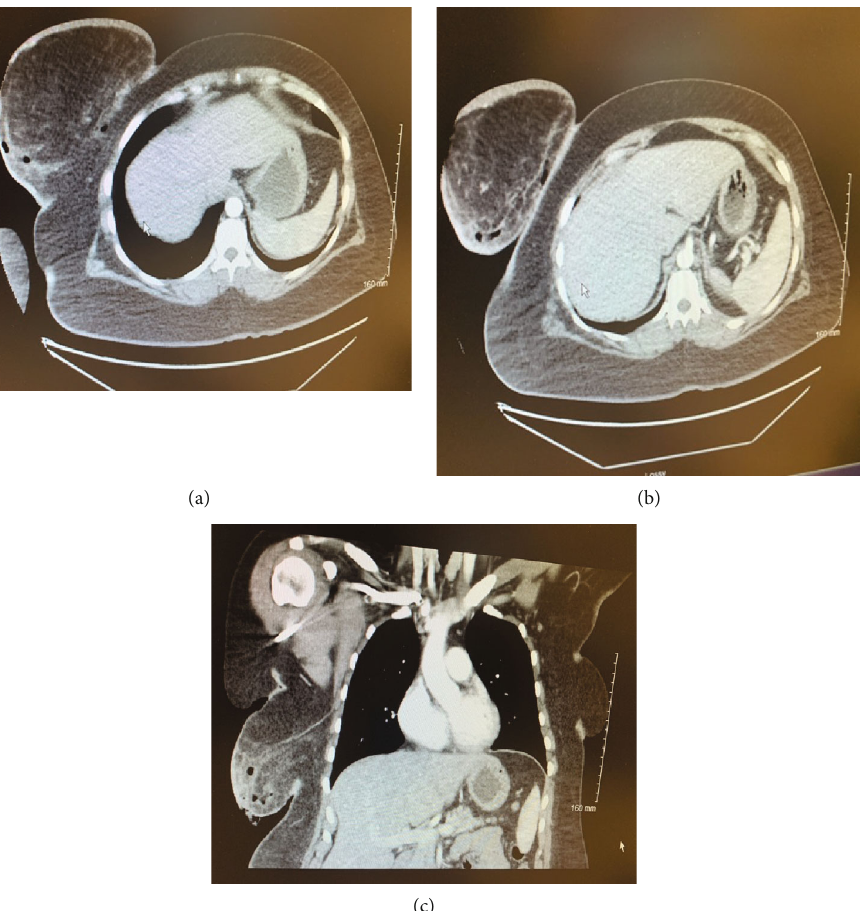
Figure 2: (a, b) Axial view of Chest CT depicting increased in fl ammation of the right breast and associated locules of gas along lateral and posterior aspect of breast. (c) Coronal view of Chest CT image showing increased attenuation of the right inferolateral breast tissue with several locules of gas. Images obtained with patient